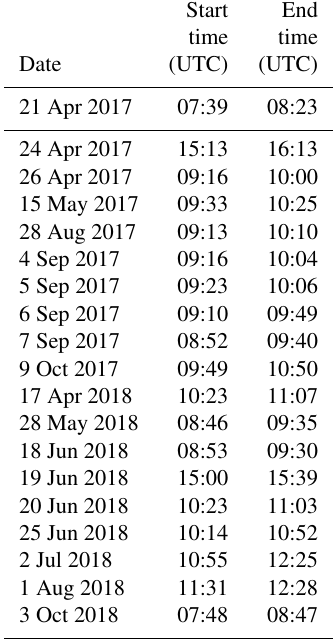
Table A2. The dates and the start and end of sampling times of AirCore flights performed in 2017 and 2018 at the Sodankylä